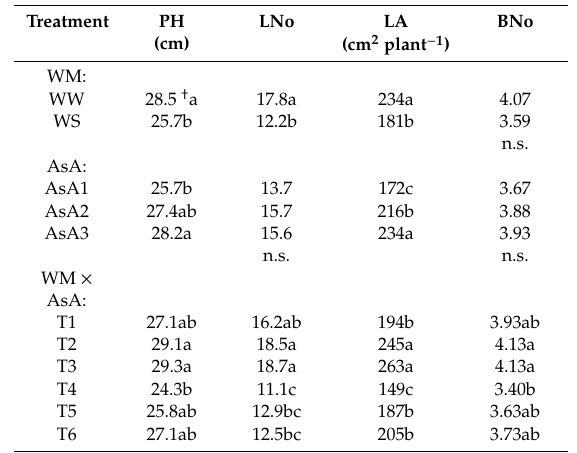
Table 6. The e ff ect of water management (WM) and ascorbic acid (AsA) on plant height (PH) (cm), leaf number per plant (LNo), leaf area per plant (LA), and branch number per plant (BNo) of common bean plants.